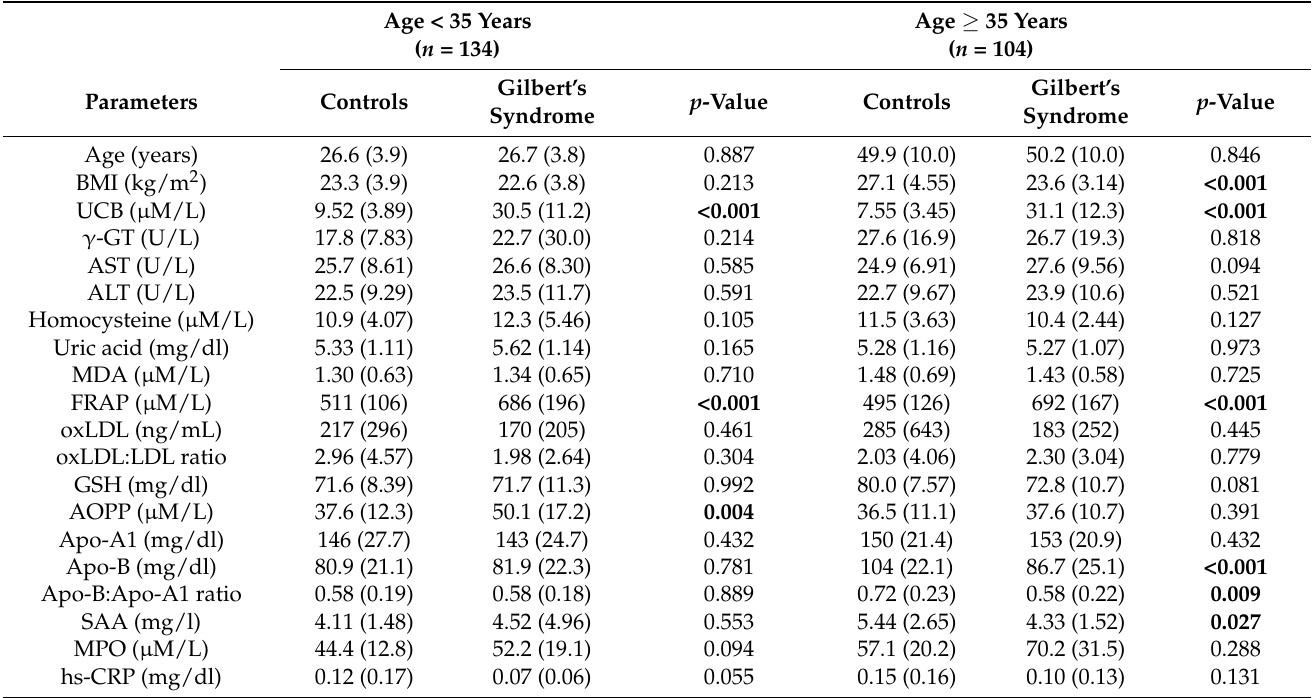
Table 2. Demographic features, biochemical parameters, biomarkers for oxidative stress and inflammation of individuals with GS and controls in two age